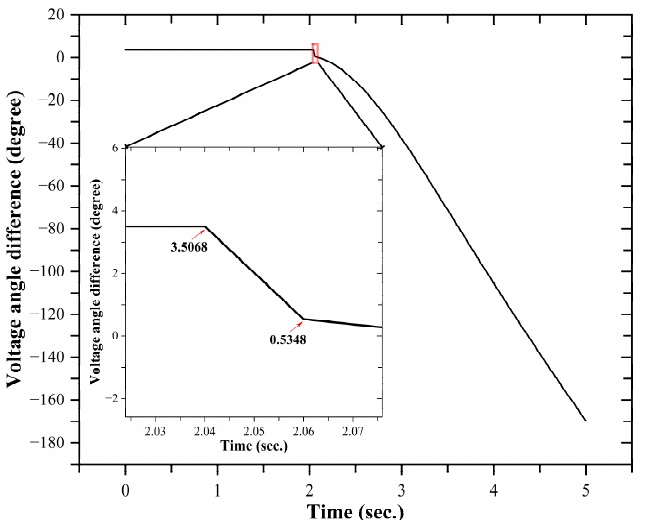
Figure 9. Proposed unintentional island threshold technique for under frequency Scenario 1.